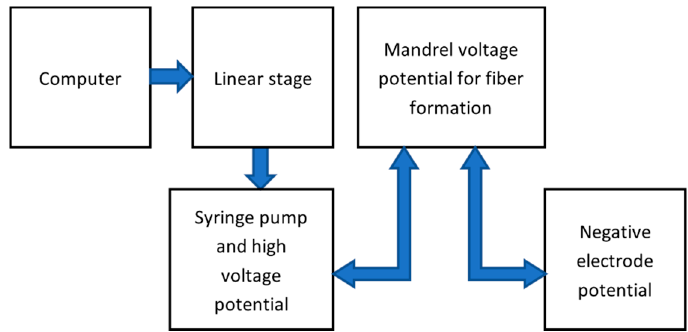
Figure 2. Schematics of the improved system.